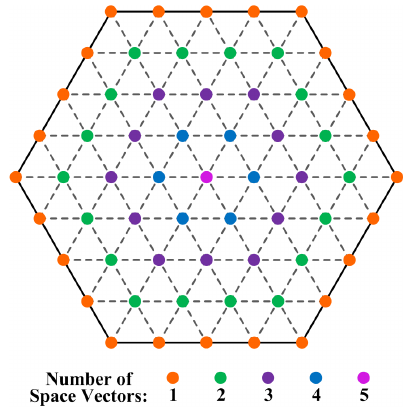
Figure 2. The voltage space vector diagram of the five-level converter.